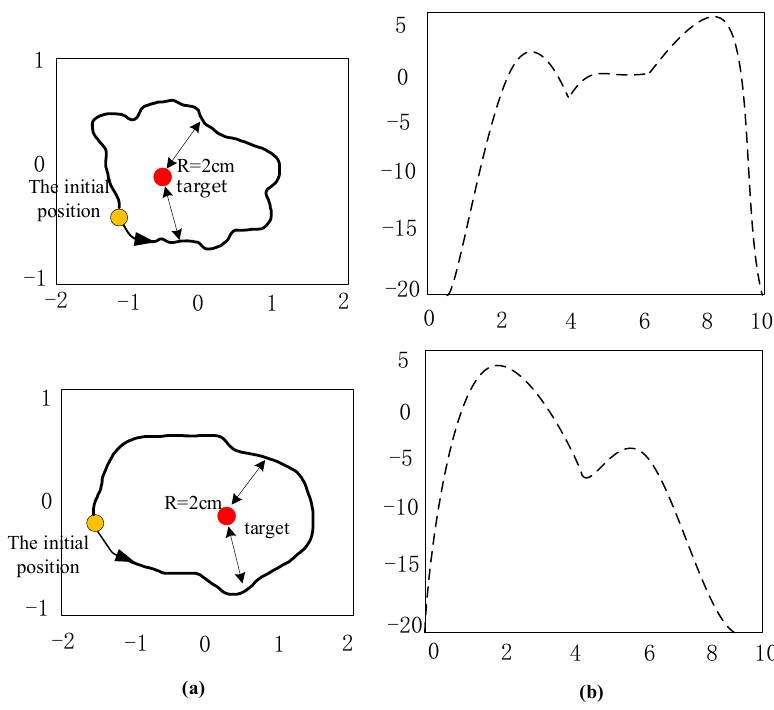
Figure 2. Target reflection patterns detected along irregular closed curves using GPR. ( a ) Target model with irregular closed curves; ( b ) distorted hyperbolas of target reflections. The black irregular closed curve is the irregular detection curve, the red circle is the internal target with a radius of 0.02 m, the yellow circle is the initial position of the radar detection, and the black arrows show the two points that reach the position of the internal target at an equal distance.